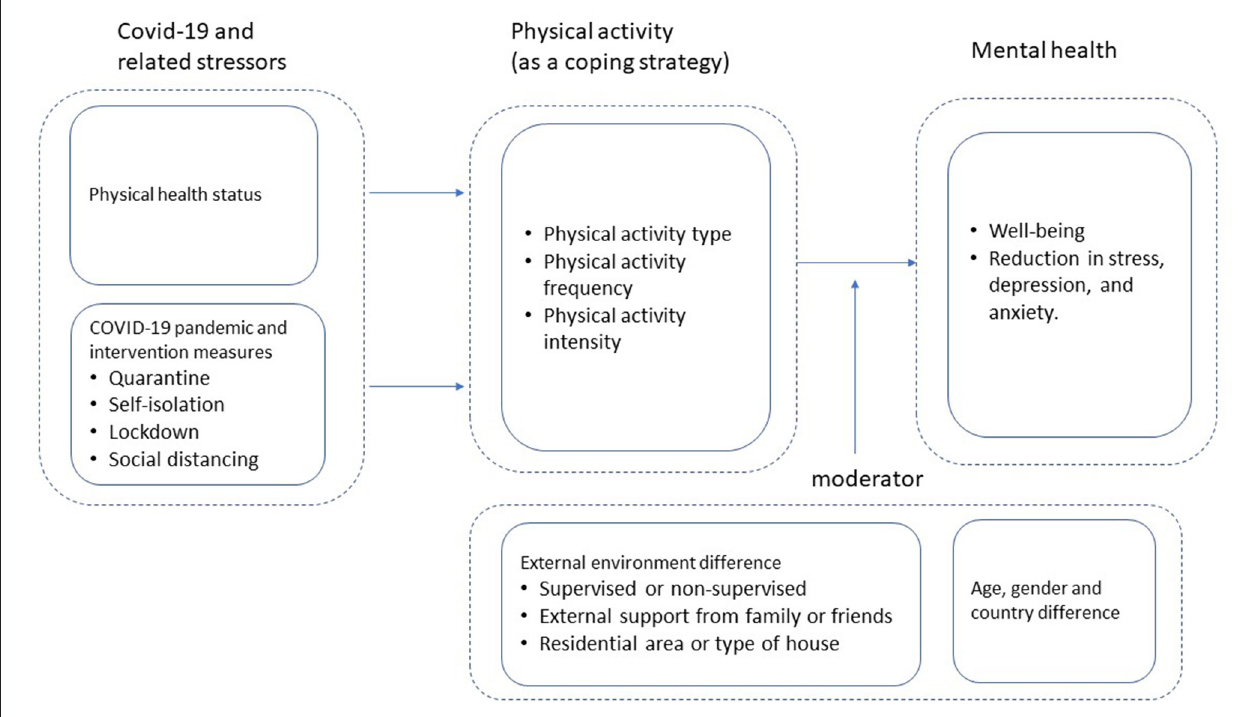
FIGURE 1 | Integrated conceptual